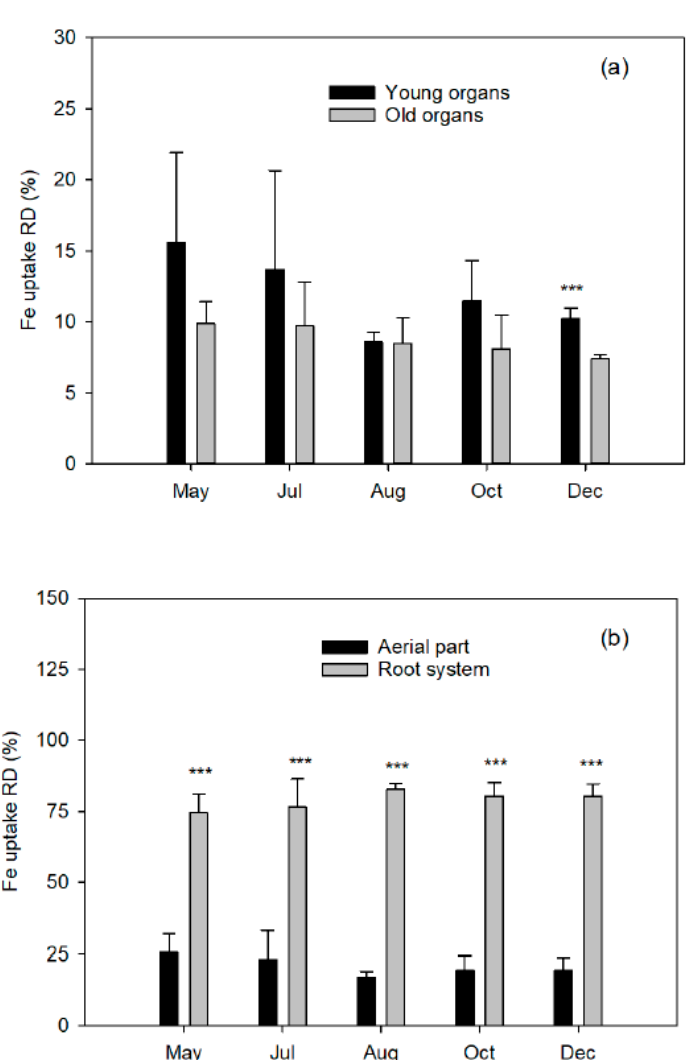
Figure 4. Relative distribution Fe uptake (Fedff W ) in ( a ) young Z and old Y organs from the aerial part in relation to the whole plant and ( b ) aerial part and root system X of Nules clementine trees uprooted in May (flowering), July (fruit set and the end of fruit drop), August (fruit growth), October (fruit growth), and December (fruit maturity). Values are means ±SD (n = 4). Significant effects of Fe dose are given at p ≤ 0.05 (*) and p ≤ 0.001 (***) at each harvest event. Z,Y,X: See Figure 1 W RD Fedff (%) organ = Σ Fedff (mg) organ × 100/ Σ Fedff (mg) plant.